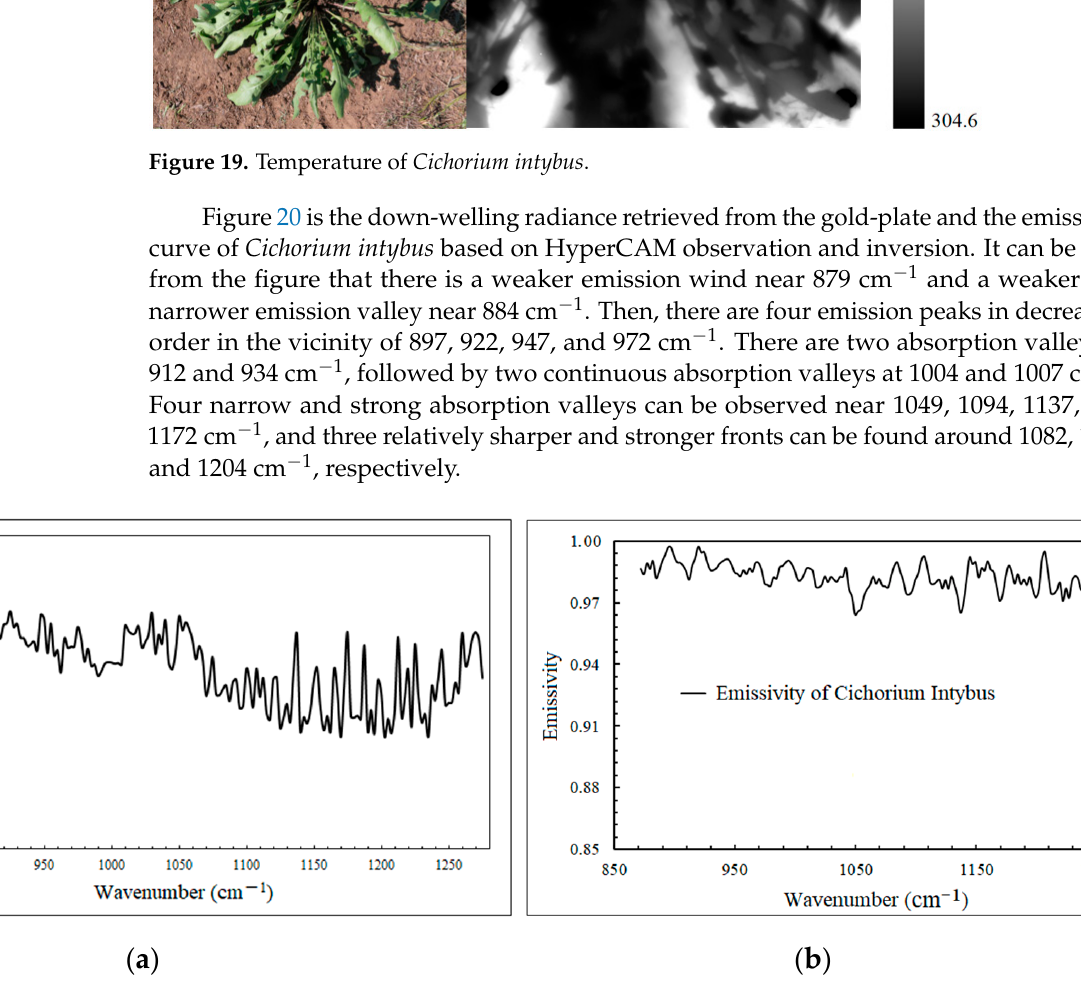
Figure 20. Results of emissivity retrieval and the down-welling radiance. ( a ) is the down-welling radiance retrieved from the gold-plate, and ( b ) the emissivity of Cichorium intybus.